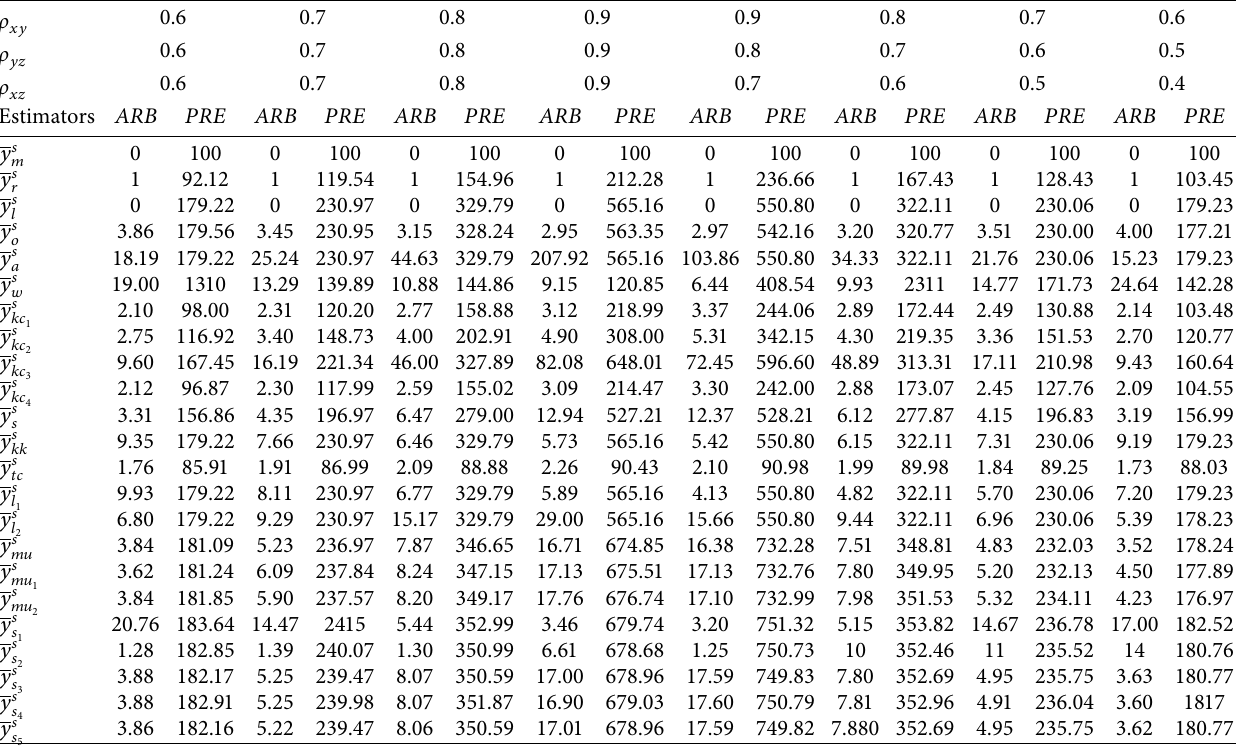
Table 2: ARB and PRE of different separate